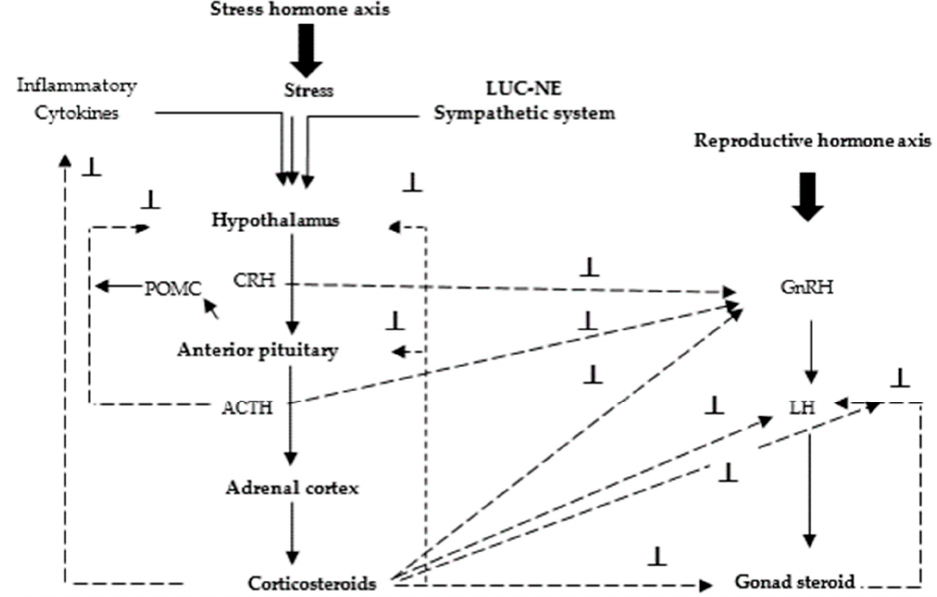
Figure 3. Hypothalamic–pituitary–adrenal axis and its impact on animal reproduction (stress hormone axis include CRH: Corticotropin ‐ releasing hormone; ACTH: Adrenocorticotropic hormone; corticosteroids contain glucocorticoids and min ‐ eralocorticoids; POMC: pro ‐ opiomelanocortin; LUC ‐ NE: locus ceruleus neurons which secrete noradrenaline; reproduc ‐ tive hormone axis includes GnRH Gonadotropin ‐ releasing hormone; LH: luteinizing hormone; gonad steroid: testos ‐ terone, estradiol, progesterone; ⊥ : inhibition. Modified after [20] .